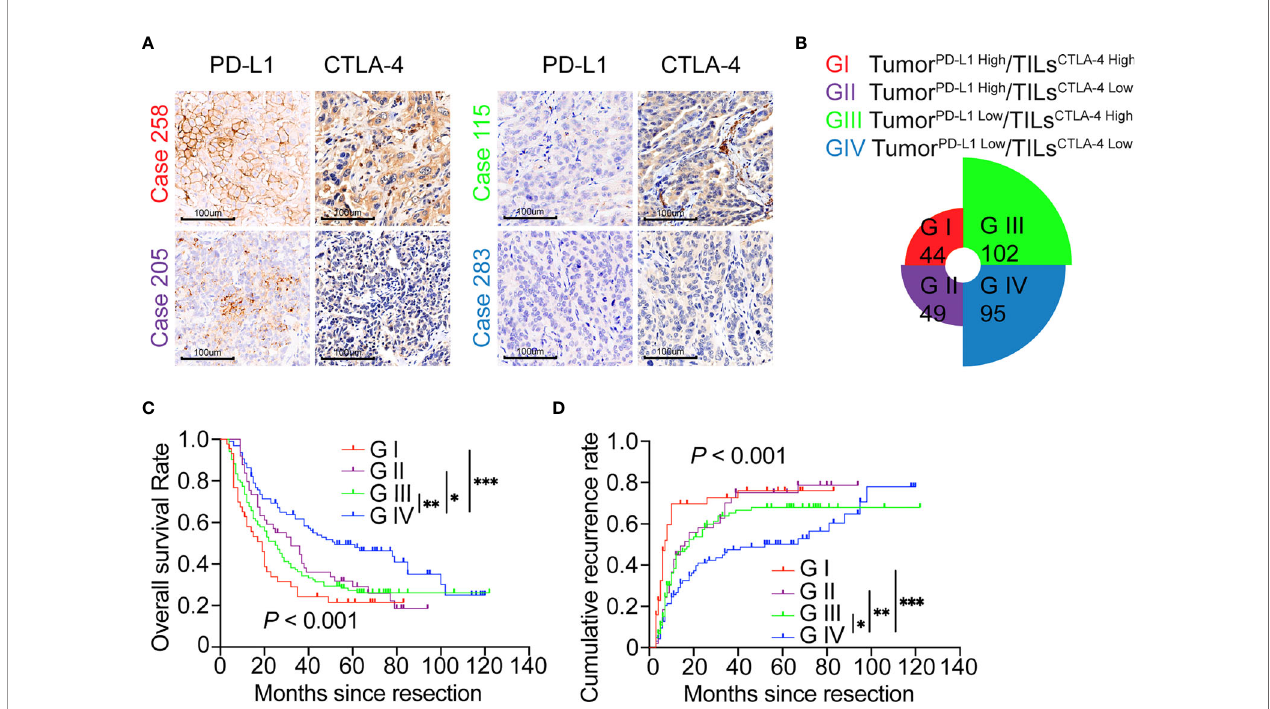
FIGURE 3 | ICC classi fi cation and combined prognostic implications of PD-L1 and CTLA-4 expression. (A, B) Classi fi cation of patients with ICC according to PD-L1 expression in tumor cells and density of CTLA-4 + TILs along with representative staining pictures for each subgroup. Magni fi cation 200x. (C) The Kaplan – Meier curve of OS shows that patients with Tumor PD-L1 High or TILs CTLA-4 High (GI/GII/GIII) are associated with worse OS compared with patients with Tumor PD-L1 Low plus TILs CTLA-4 Low (GIV). (D) The Kaplan – Meier curve of cumulative recurrence shows that patients with Tumor PD-L1 High or TILs CTLA-4 High (GI/GII/GIII) are associated with higher cumulative recurrence rates compared with patients with Tumor PD-L1 Low plus TILs CTLA-4 Low (GIV). * P < 0.05, ** P < 0.01, and *** P <